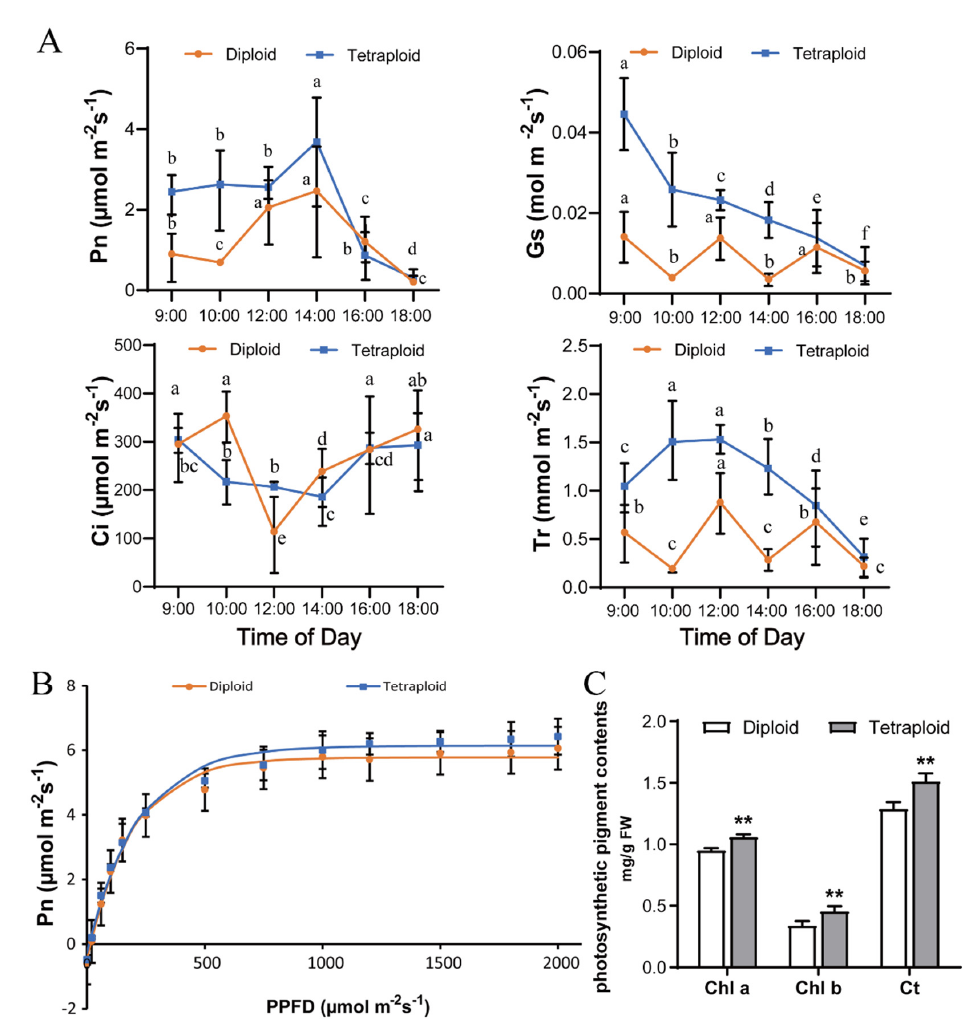
Figure 5. Photosynthetic parameters of the hybrid allotetraploid lily and its allodiploid counterpart. ( A ) Diurnal variation in photosynthetic parameters, including the net photosynthetic rate (Pn), sto ‐ matal conductance (Gs), transpiration rate value (Tr), and intercellular carbon dioxide concentration (Ci), in allodiploid and allotetraploid plants. The values represent the means ± SDs of at least